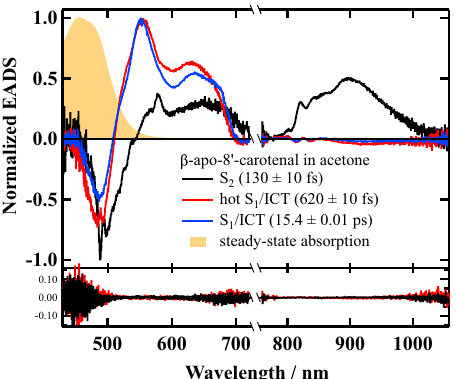
Fig. 5 EADS obtained by the global analysis against the entire observed dataset of femtosecond time-resolved absorption spectra of β -apo-8 ′ - carotenal in acetone. The results of global analysis based on a sequential model for β -apo-8 ′ -carotenal in acetone in the visible and near-infrared spectral regions when excited at 490 nm are shown. The fi rst (solid black line) and second (solid red line) right singular value vectors of the residual matrix, which corresponds to the residuals of the fi ttings, is shown at the bottom. Steady-state absorption spectrum of β -apo-8 ′ -carotenal in acetone is also shown for comparison.